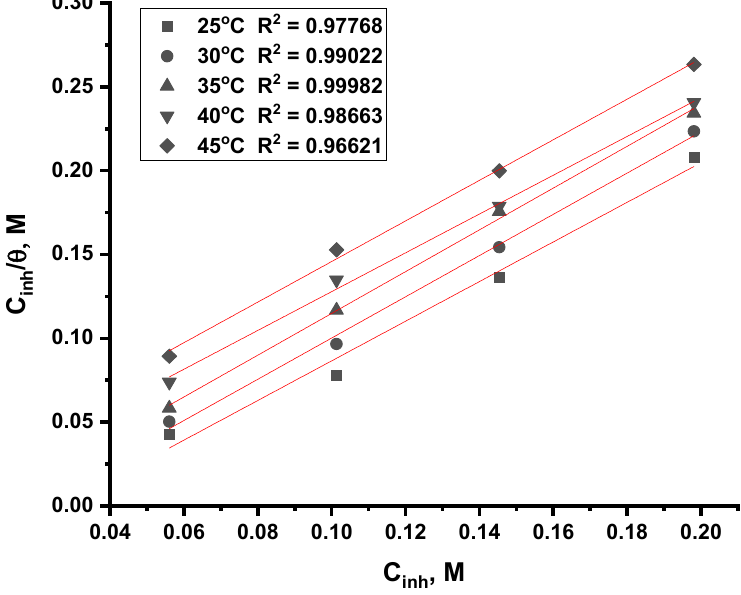
Figure 11. Langmuir adsorption plot as C / θ vs. C , M of ACR-3 for corrosion of copper in 1.0 M HNO 3 solution at all temperatures. Table 4. Thermodynamic adsorption coefficients of ACR-2 on Cu substrate in 1.0 M HNO 3 . Temp., ° C